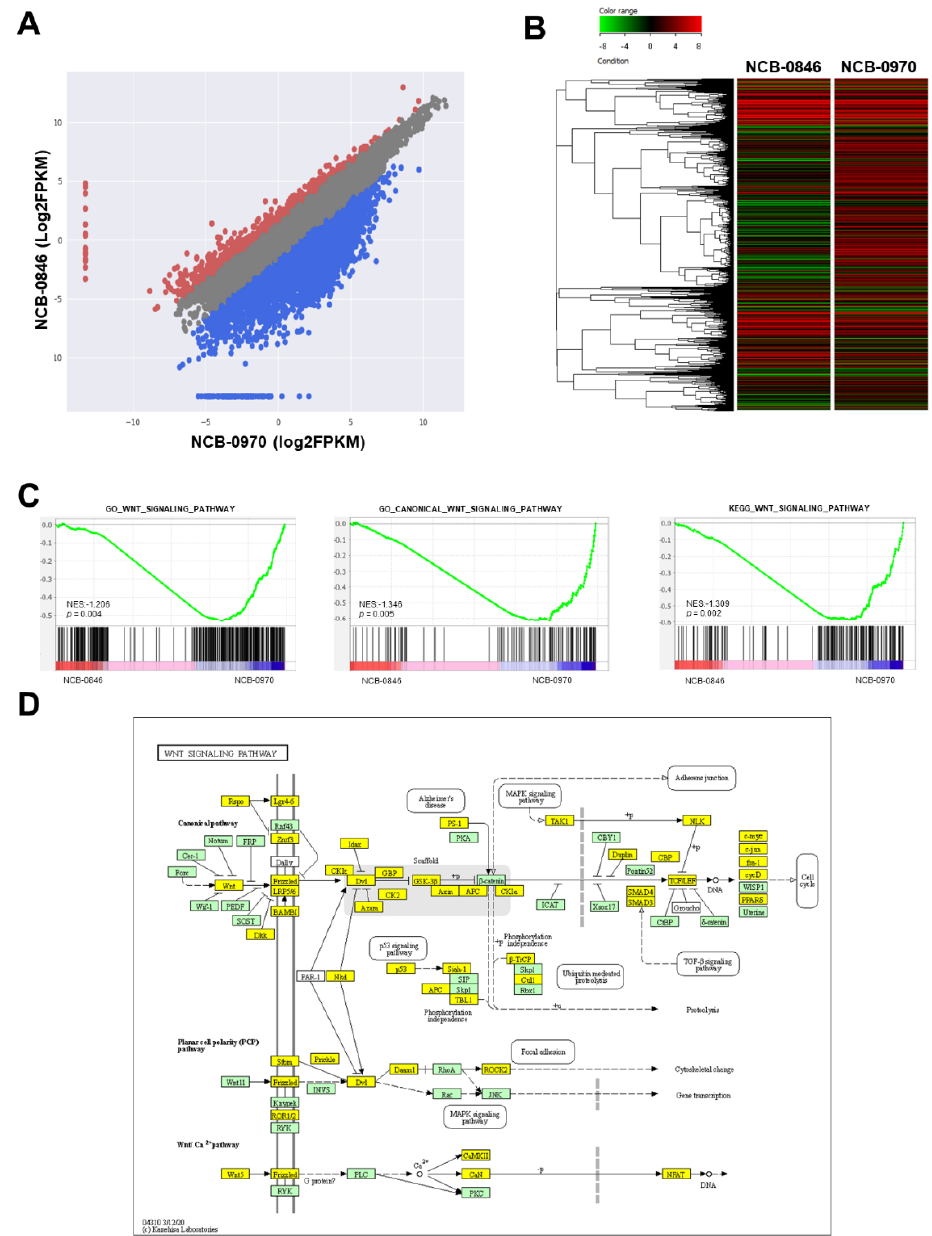
Figure 4. Gene expression profiling of synovial sarcoma cells treated with NCB-0846. ( A ) Scatter plot of genes di ff erentially expressed between cells treated with NCB-0846 and NCB-0970 (negative control). Red dots represent genes upregulated more than 2-fold, and blue dots represent genes downregulated more than 2-fold in cells treated with NCB-0846. ( B ) Heat map plot of genes di ff erentially expressed between NCB-0846 and NCB-0970. The upper color bar represents the degree of di ff erential expression. ( C ) Gene set enrichment analysis (GSEA) showing the significant enrichment of genes annotated to the gene ontology (GO) terms “Wnt signaling pathway” ( p = 0.004) and “canonical Wnt signaling pathway” ( p = 0.005) and to “Wnt signaling pathway” deposited in the KEGG database ( p = 0.002). NES: normalized enrichment score (http: // software.broadinstitute.org / gsea / index.jsp). ( D ) Mapping of di ff erentially expressed genes onto the Wnt signaling pathway. Yellow boxes indicate genes downregulated ( > 2-fold) by